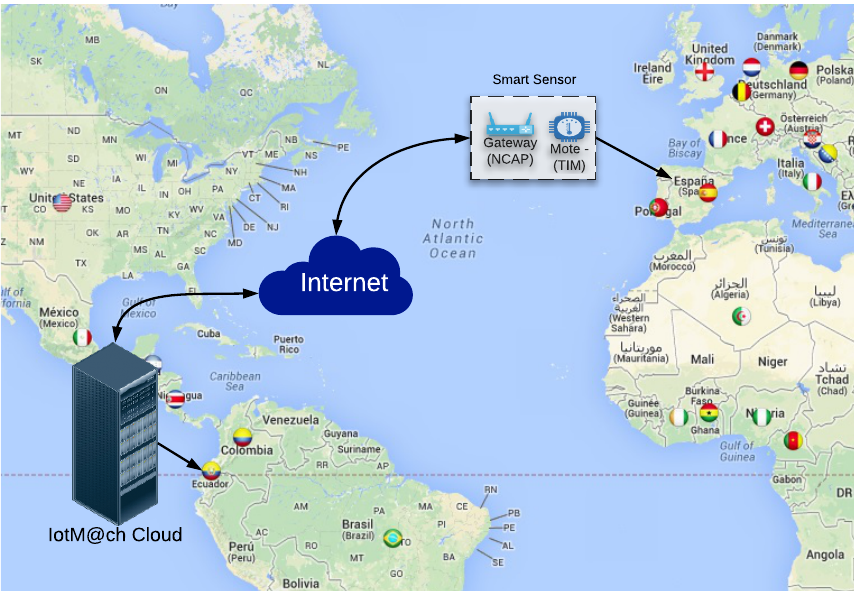
Figure 26. Physical distribution of the IoT